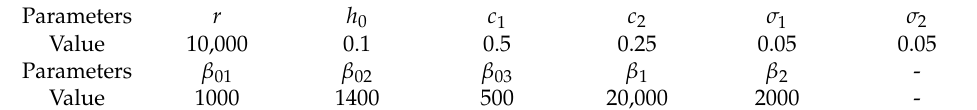
Table 1. Parameters of active disturbance rejection controller simulation under step signal.